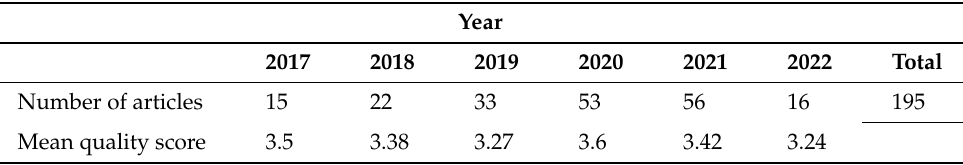
Table 3. Average quality scores for articles by publication